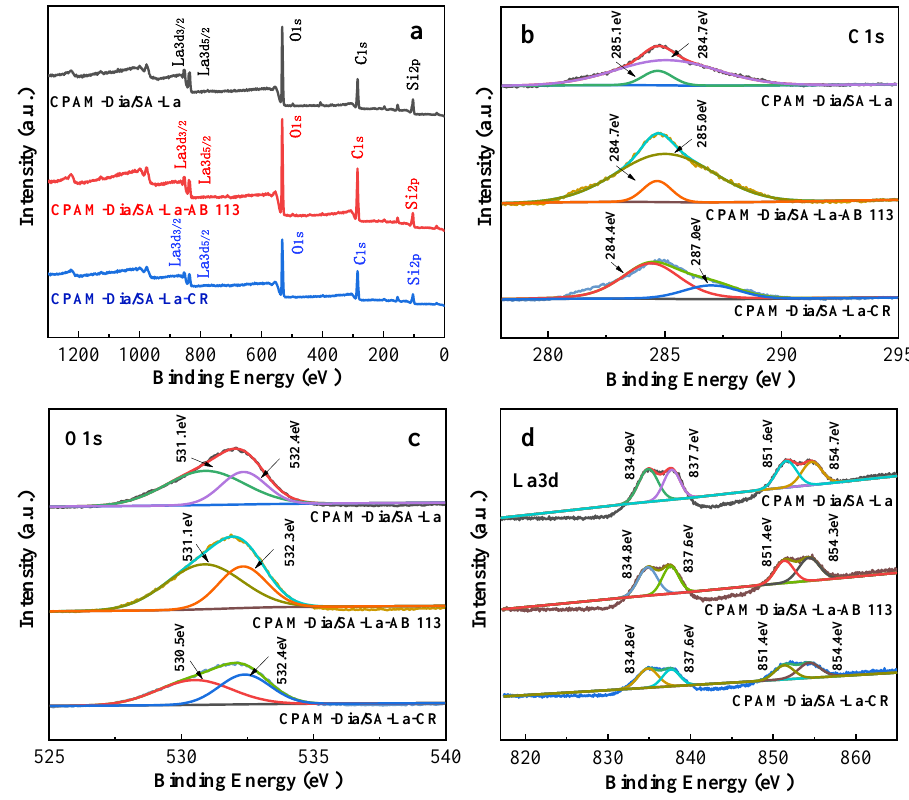
Figure 6. XPS spectra of the gel composite before and after dye adsorption ( a – d ).